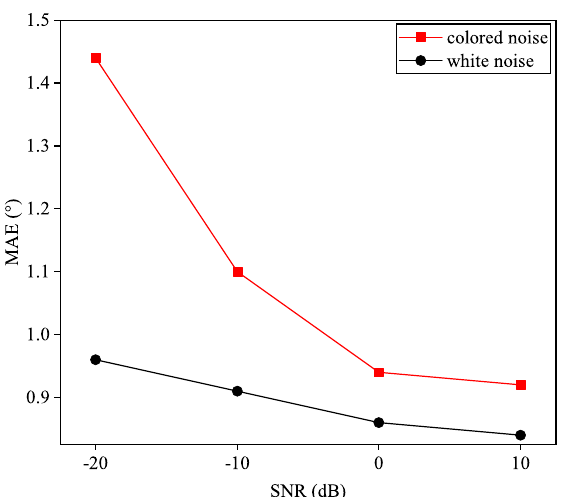
Figure 12. Performance of the Toeplitz A-CRNN models to colored noise while trained in